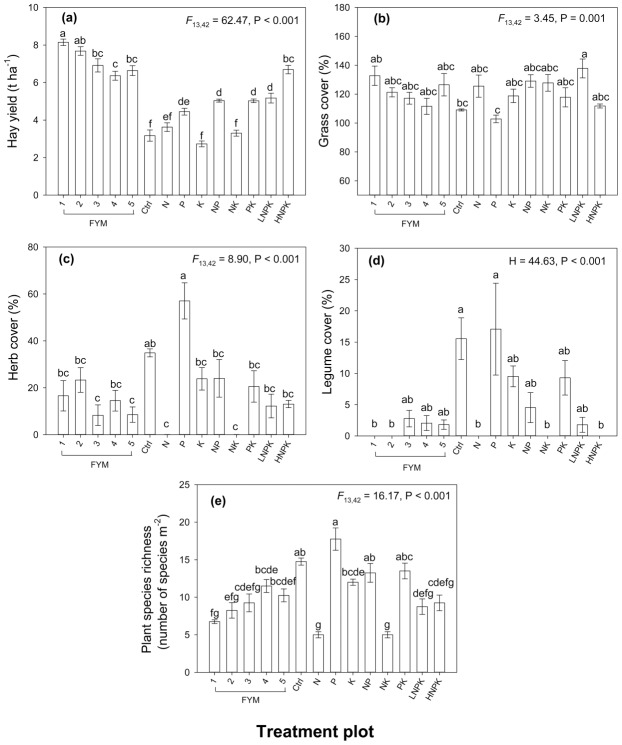
Effect of fertilizer treatment plot on (a) hay yield, (b) grass cover, (c) herb cover, (d) legume cover and (e) plant species richness. Error bars represent ±1 standard error of the treatment plot mean and contrasting letters denote significant differences between treatment plots. H is the Kruskal-Wallis test statistic.